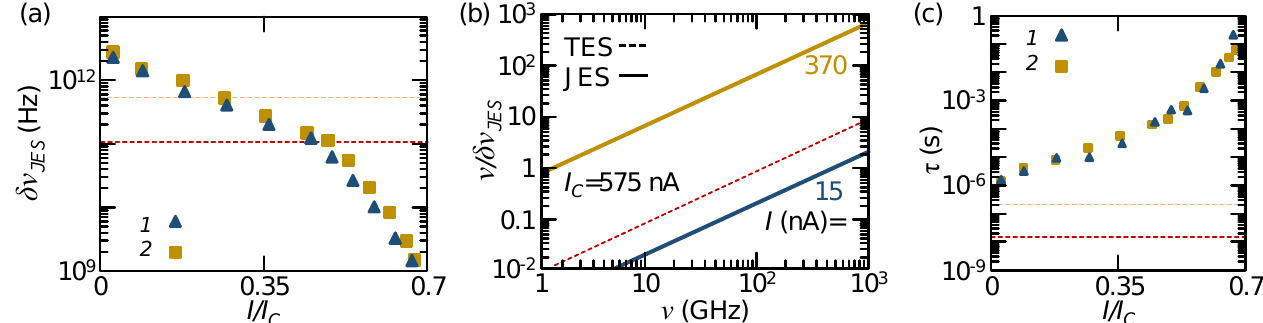
Figure 7. Performance calculated for the JES. ( a ) Frequency resolution δν JES as a function of I for sample 1 (blue triangles) and 2 (yellow squares). The dashed lines indicate the frequency resolutions of the corresponding nano-TESs. ( b ) Resolving power ( ν / δν JES ) as a function of the frequency ( ν ) of the incident single-photons calculated for sample 1. The dashed lines indicate the resolving power of the corresponding nano-TES. ( c ) Time constant versus bias current for sample 1 (blue triangles) and 2 (yellow squares). The dashed lines indicate the time constants of the corresponding